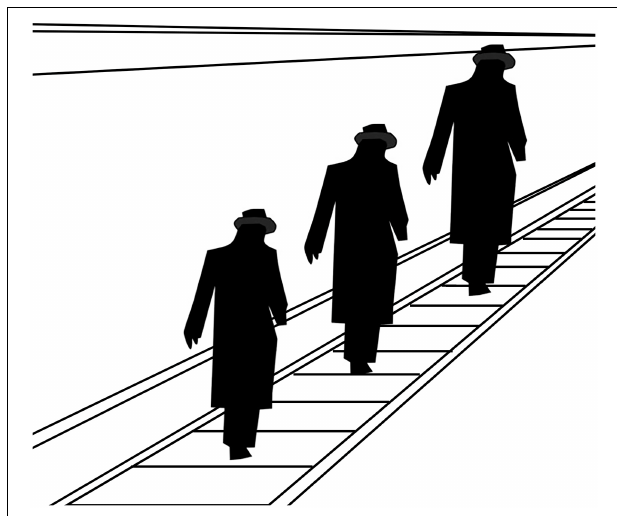
FIGURE 6 | The “men in a tunnel illusion.” Based on the image included by Ernst Gombrich in Art and